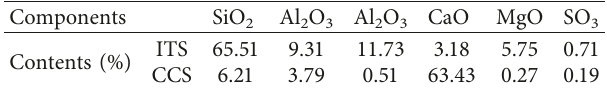
Table 2: Chemical component of iron tailing sands and calcium carbide slag.